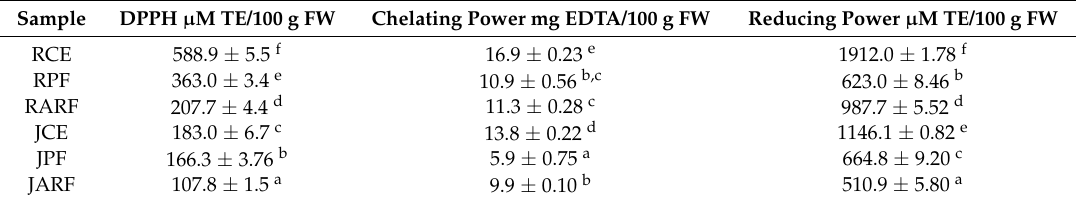
Table 3. Antioxidant capacity of analyzed samples, measured by different complementary